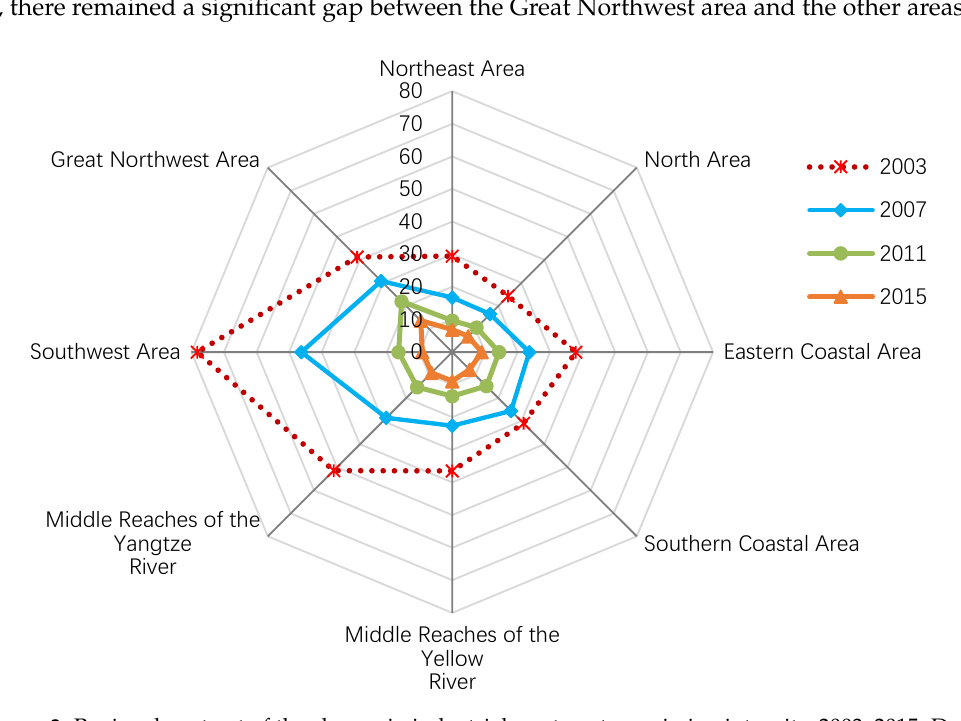
Table 3. Decomposition results of factors affecting IWEI change.